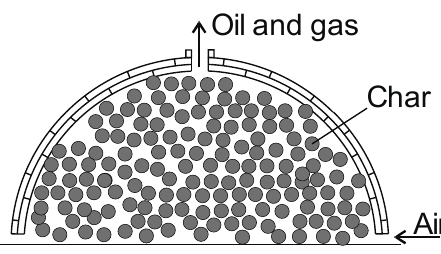
Figure 6. Kilns made from brick used for the char production.